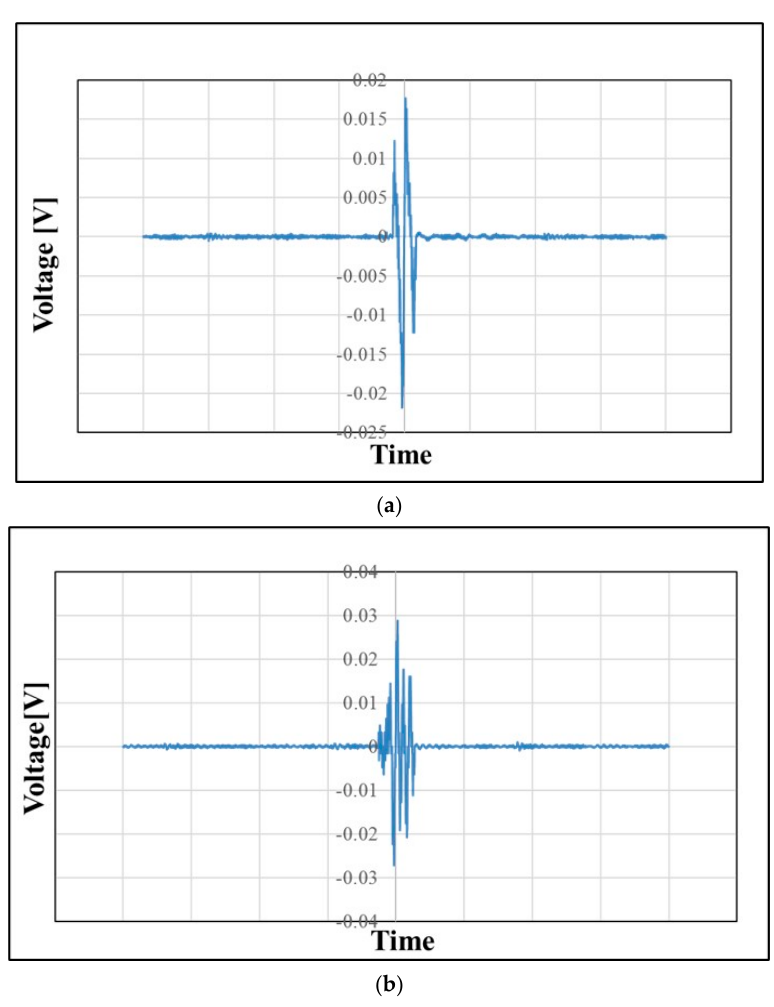
Figure 18. Voltage spike for PAN membrane sensors: ( a ) atmospheric plasma (corona discharge) treated and ( b ) (corona discharge + heat)-treated. Table 4. Voltage, Capacitance, and piezoelectric coefficient (d 33 ) response measurements for Con- trol; Heat treated; Atmospheric plasma (corona discharge) treated and Heat & Corona discharge treated samples.